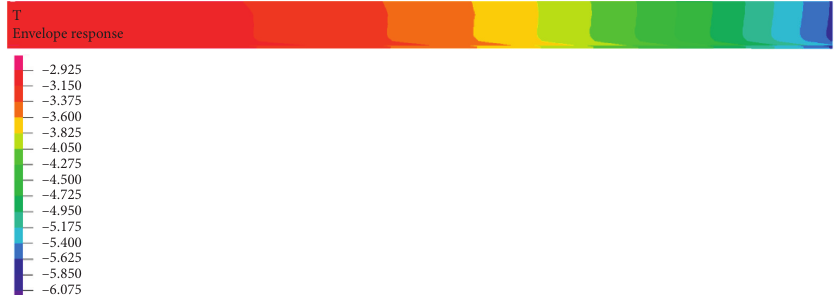
Figure 23: Annual average air temperature distribution outside the lining in the tunnel axis with a thermal conductivity of 0.03W/(m · ° C).